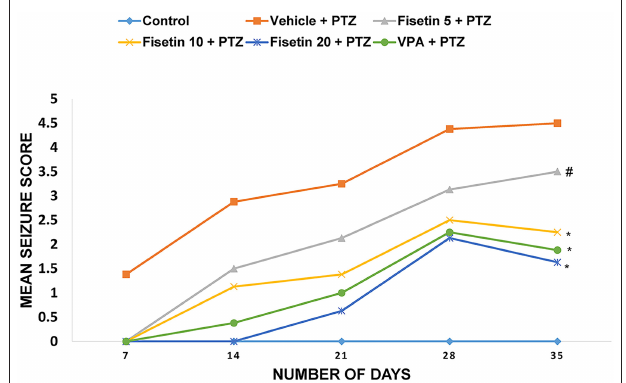
FIGURE 1 | Effect of fisetin administration on mean seizure scores in kindled mice on 7th, 14th, 21st, 28th, and 35th day of dosing. Fisetin administration significantly decreased the mean seizure score and increased the latency for seizure generation. Fisetin administration in doses (10 and 20 mg/kg, p.o.) inhibited the development of fully kindled seizures. Fisetin administration prevented mortality during the kindling procedure. Data were analyzed by one-way ANOVA followed by Tukey’s multiple comparison test ( n = 8) and expressed as mean ± SEM. # p < 0.05 as compared with vehicle + PTZ group and * p < 0.001 as compared with vehicle + PTZ group.